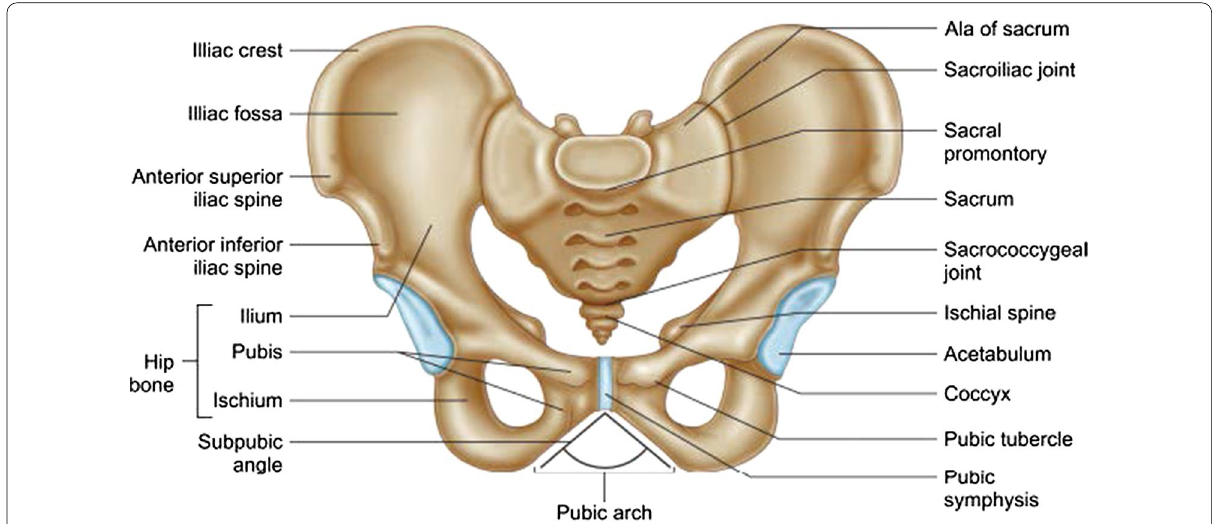
Fig. 1 Anatomical illustration of the pelvic girdle and pelvis (Kotarinos